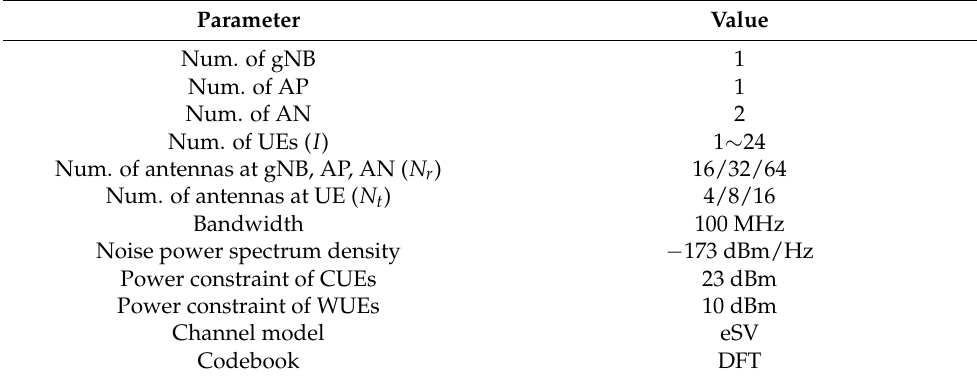
Table 1. Simulation